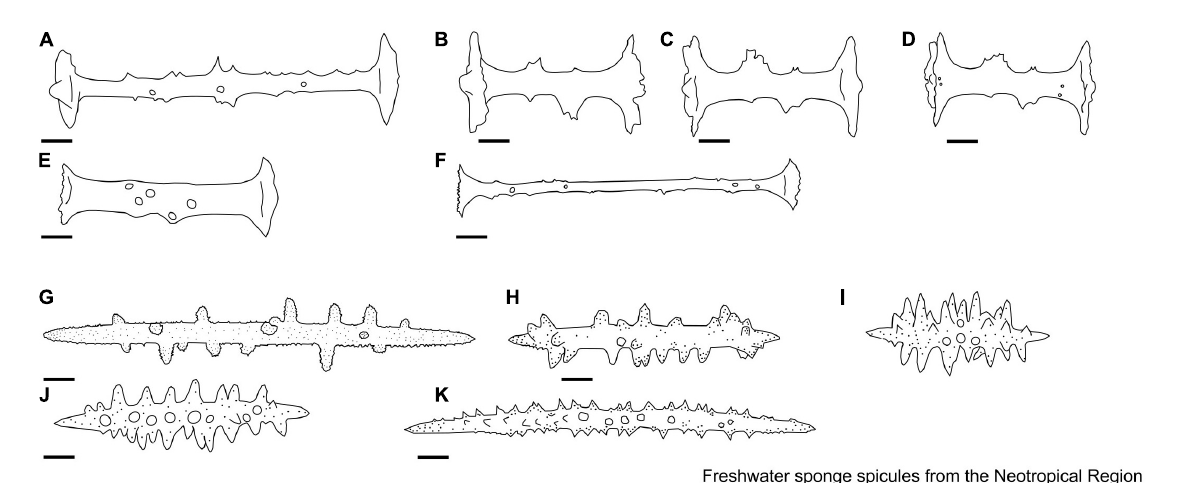
FIGURE6 (A–F) Heterorotula Penney & Racek, 1968. Gemmuloscleres. (A) Birotule with long axis, with almost flat rotules; (B–D) birotules with short axis, rotules with irregular edges, some large and irregular spines; (E) birotules with short axis, with incomplete rotules; (F) birotules with long axis, with incomplete rotules. (G–K) Pottsiela Volkmer-Ribeiro, Machado, Fürstenau-Oliveira & Soares, 2010. Microscleres. (G–K) Acanthoxeas with microspined bearing along its length, conical spines also microspined. Scale: 10 µ m.